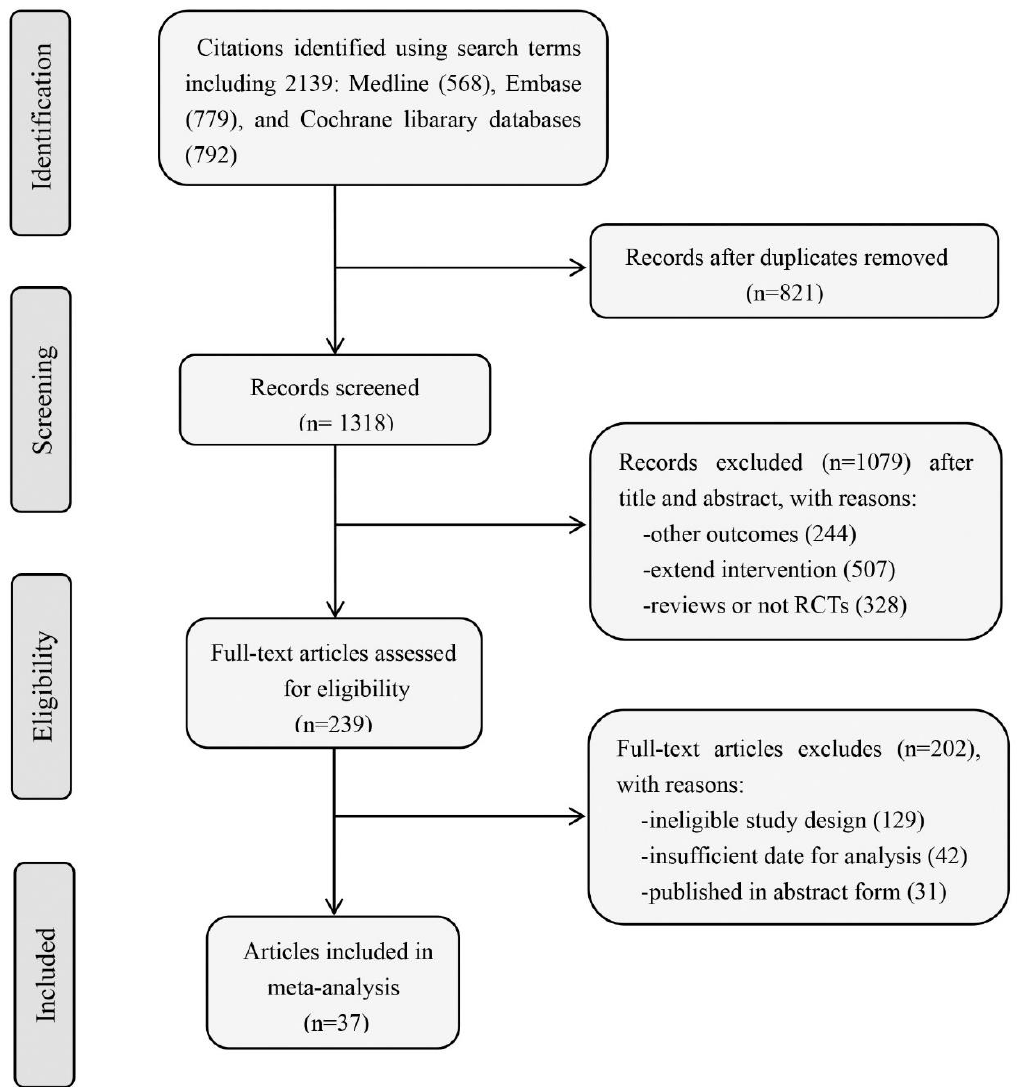
Figure 1. Flow chart of study selection procedure. Table 2. Summary of results stratified by JAKinibs compared to placebo corresponding to respective A total of 37 RCTs and 15,174 participants in total were enrolled in this systematic review and meta-analysis, including 12 tofacitinib, 6 baricitinib, 6 upadacitinib, 3 decerno- tinib, 5 peficitinib, and 5 filgotinib. The baseline patient characteristics of trials are shown in Table 1. Duration of treatment ranged from 4 to 24 weeks. The characteristics of the included trials are summarized in Table 1. Key findings are summarized in Table 2. Table 1. Characteristics of included trials. Only data including placebo and the doses of interest are selected; therefore, the selected study duration is different from the original research.